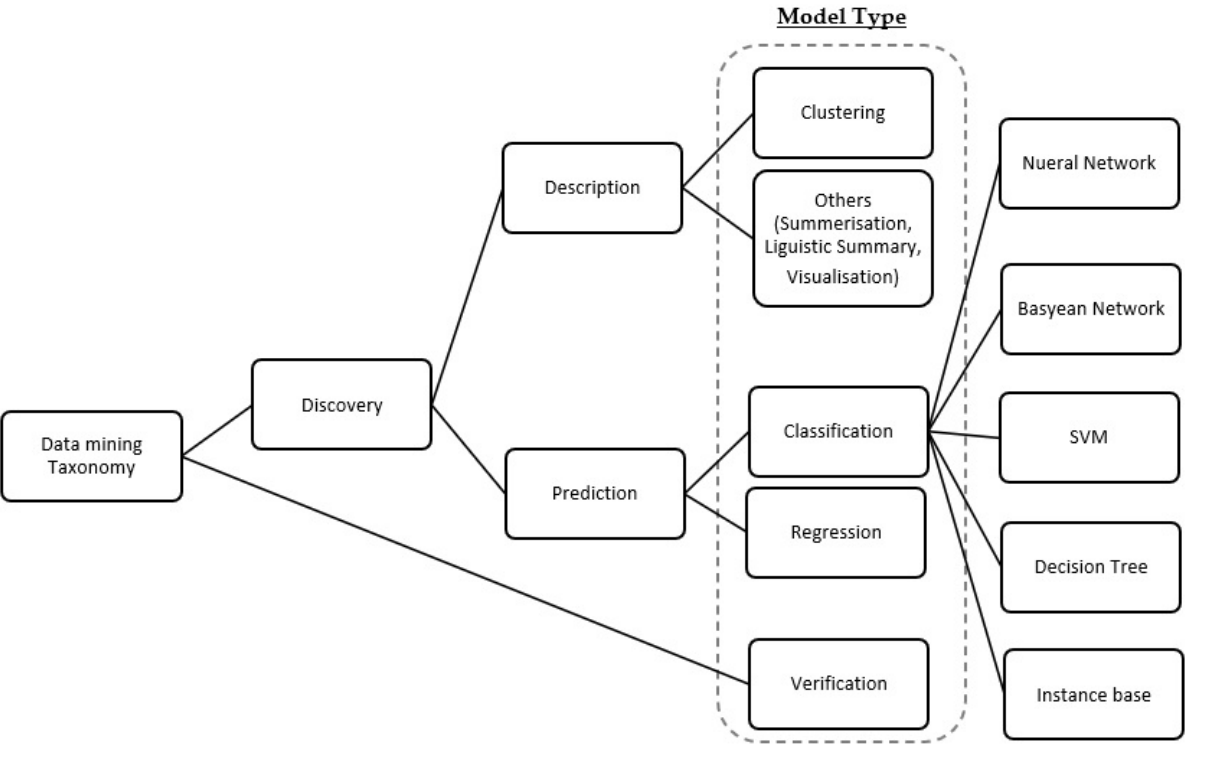
Figure 3. Data mining taxonomy and model type classification for segregating different modelling